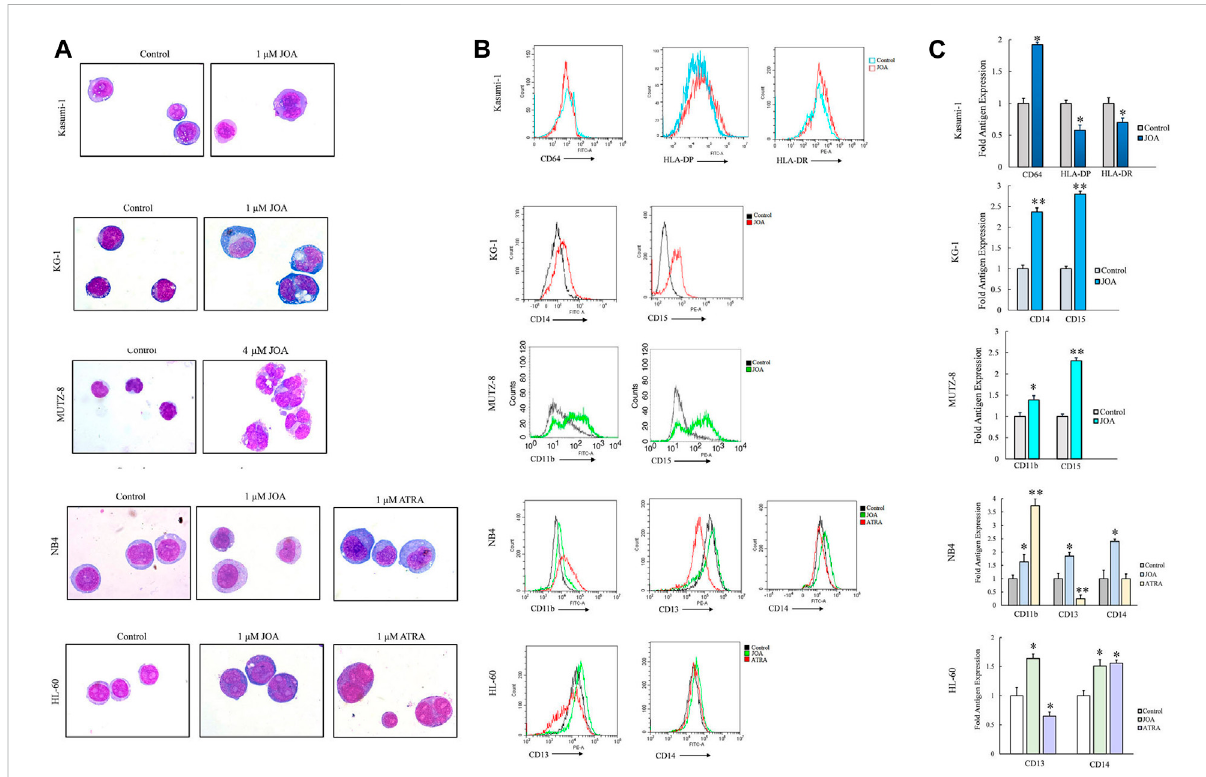
FIGURE 5 JOA induced the differentiation of Kasumi-1, KG-1, MUTZ-8, NB4, and HL-60 cells based on morphological features and cell membrane markers. (A) Wright – Giemsastainingonthemorphologicalchangesofcellscapturedbyanoilimmersionlens(1,000×). (B) Expressionofcellsurface antigens. (C) Graphbarspresentingthemean fl uorescenceintensityofantigens(* p < 0.05and** p < 0.01).Cellswereincubatedwith1,1,4,1,or1 μ M of JOA, respectively for 72